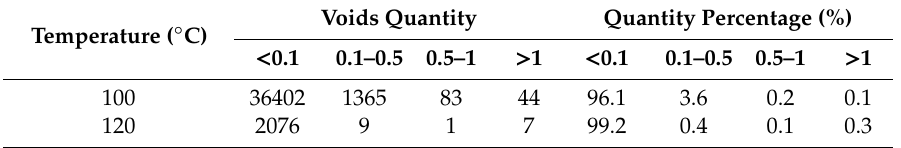
Table 6. Quantity of voids in asphalt.